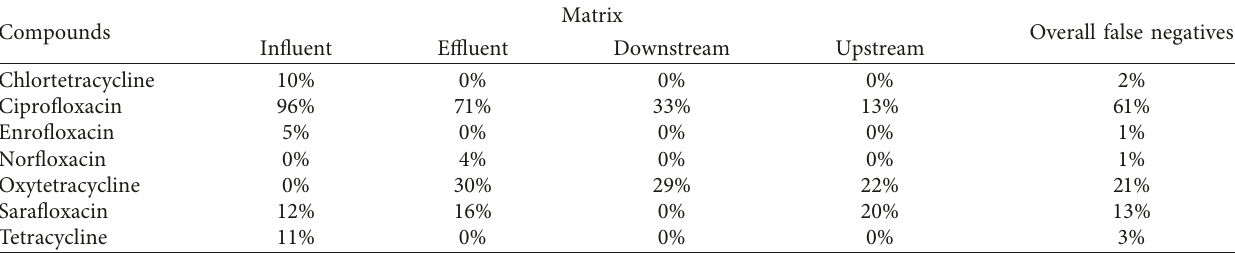
Table 4: Percent false negatives for tetracyclines and quinolones at the 50% tolerance range in spiked environmental matrices. Compounds